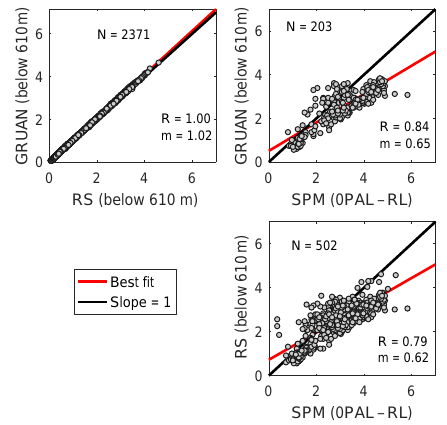
Figure 13. Comparisons between the partial columns of water vapour between the two measurement sites (the Ridge Lab and 0PAL) using data from the SPMs and